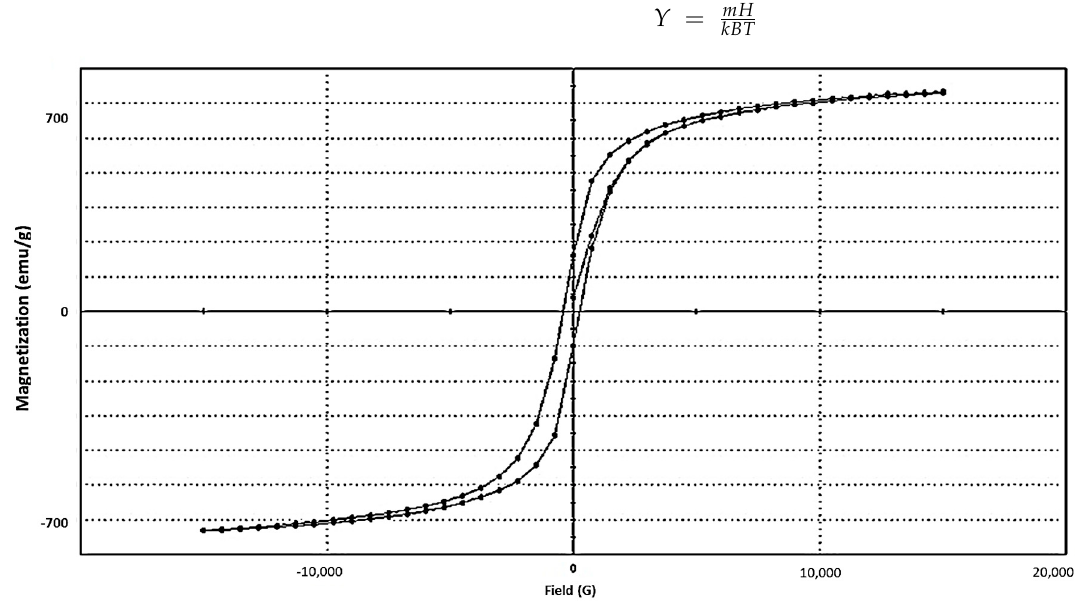
Figure 5. VSM measurement of IONPs.